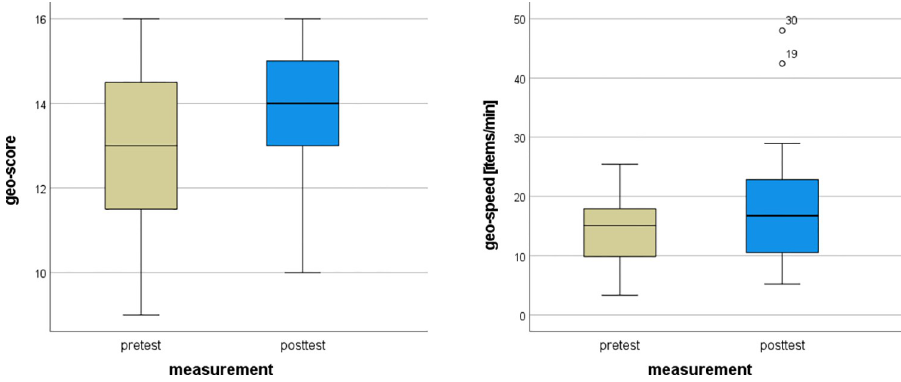
Fig 5. Pretest and posttest values for score and speed in geo tests for individual